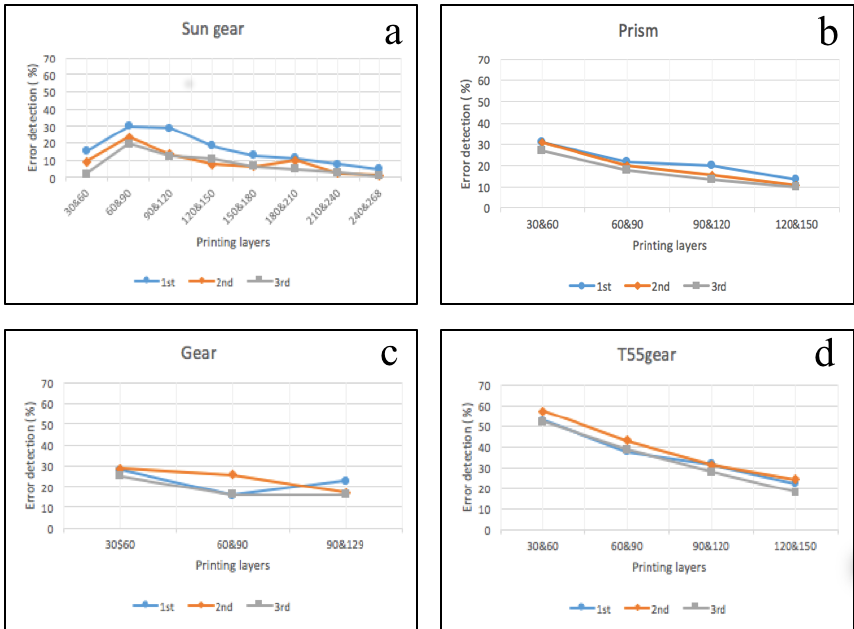
Figure 16. Image pre-processing—Non-rescale and rectification: the error detection of failure state for ( a ) sun gear; ( b ) prism; ( c ) gear; and ( d ) t55gear.